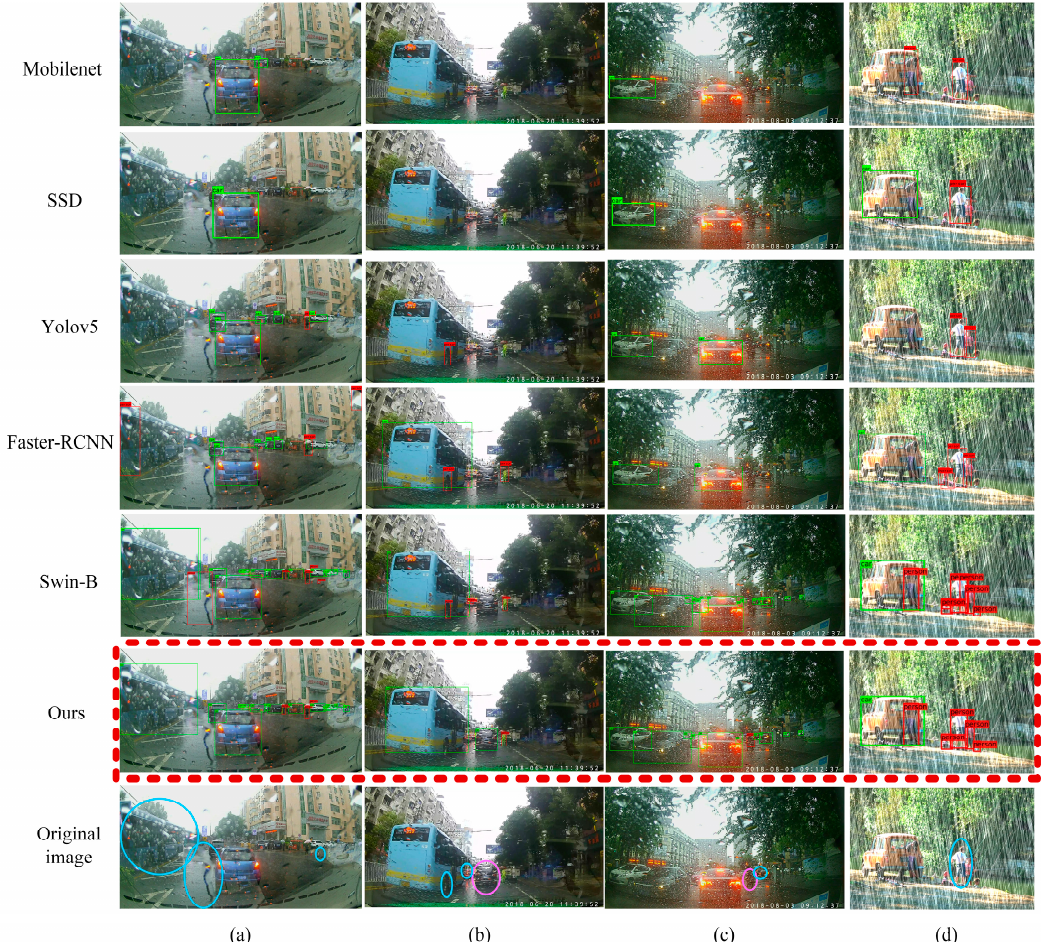
Figure 8. The qualitative comparisons of the detection results between the PVformer and the current